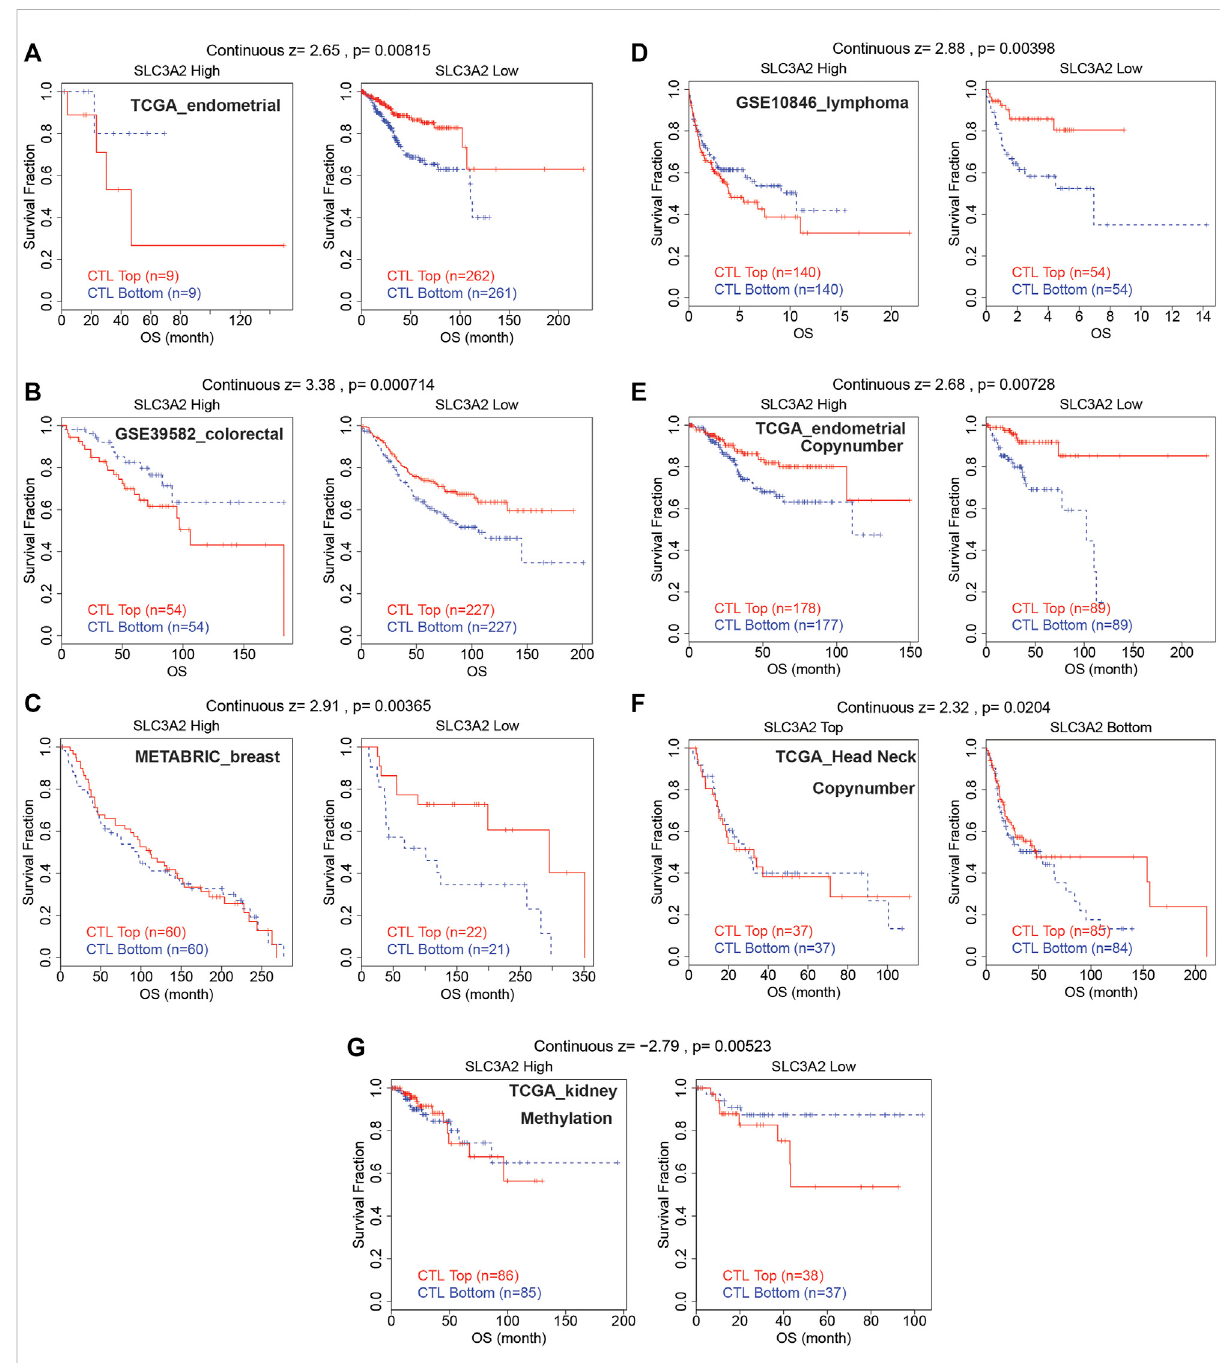
FIGURE 6 Cytotoxic lymphocyte was associated with better prognosis only in samples with low SLC3A2